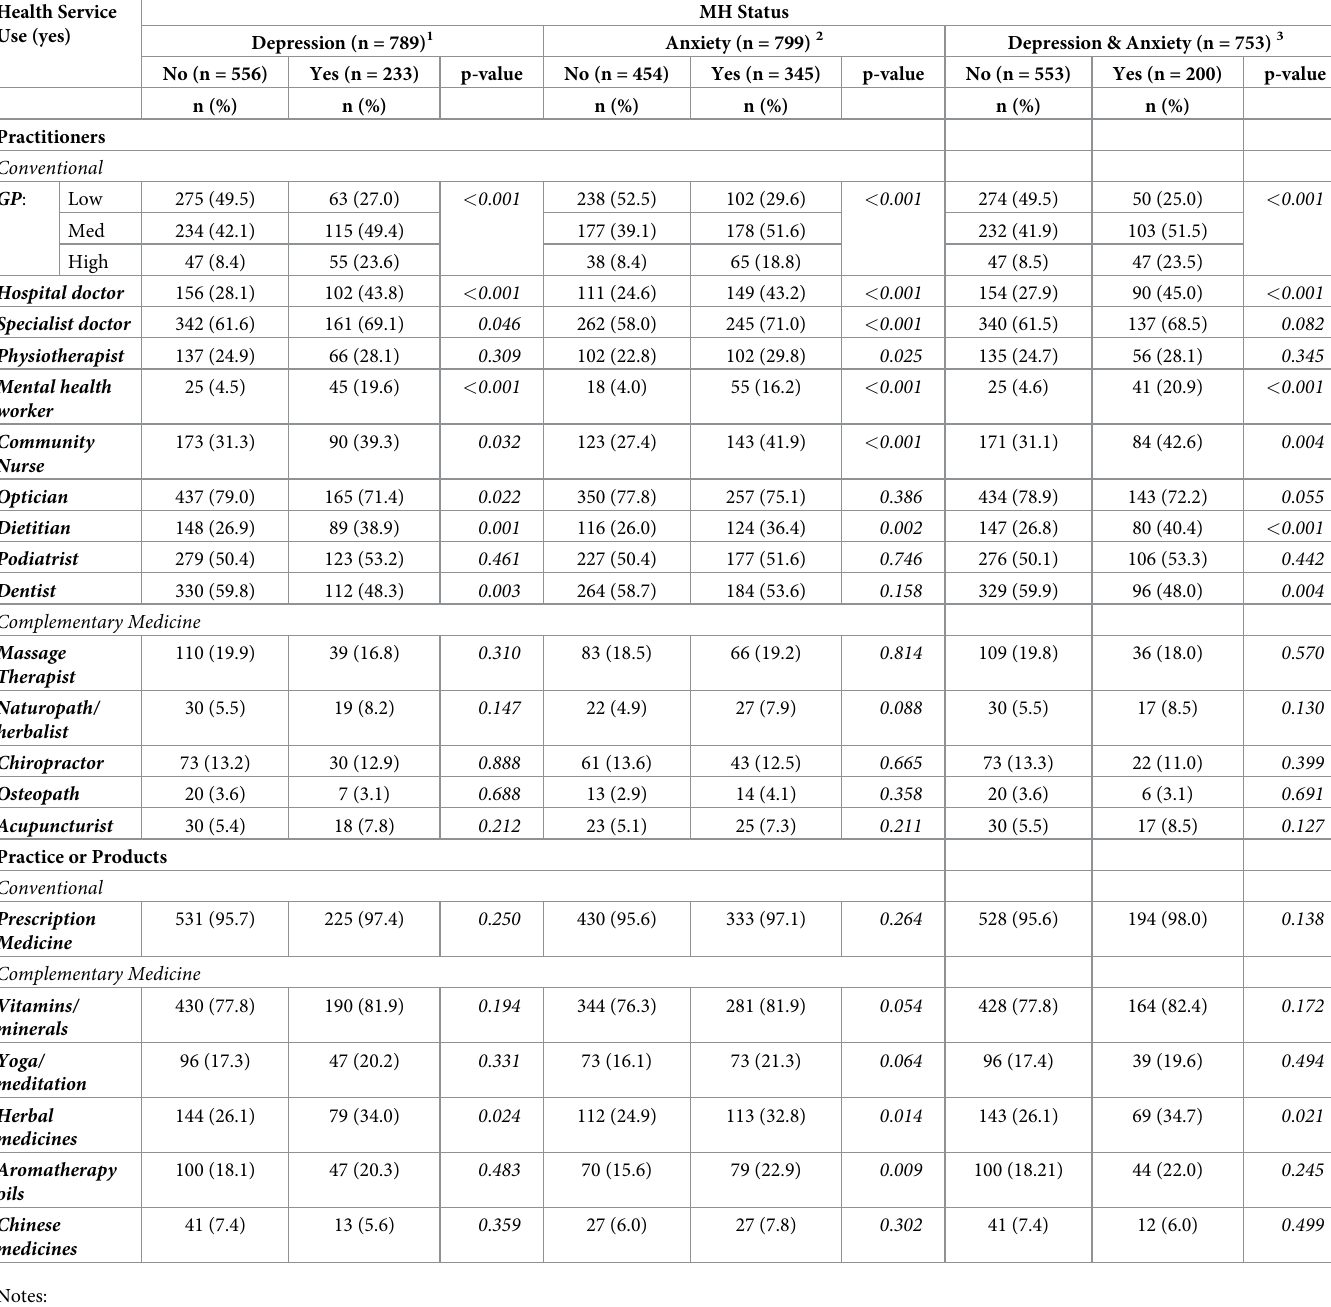
Table 3. Prevalence of health service use of women with diabetes mellitus by mental health